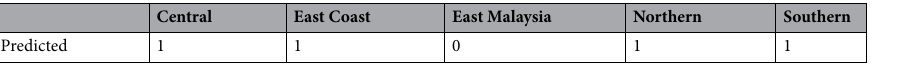
Table 12. Predicted Influenza Outbreaks for Next Week 22 to 28 Jul 2019 with Optimal Parameter: Kernel = rbf, w=3 1 represents outbreak, and 0 represents non-outbreak.